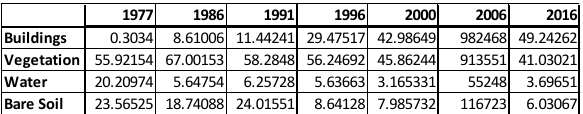
Table 2: The percentage of area and expansion of Land cover classification in different year of Shenzhen city .